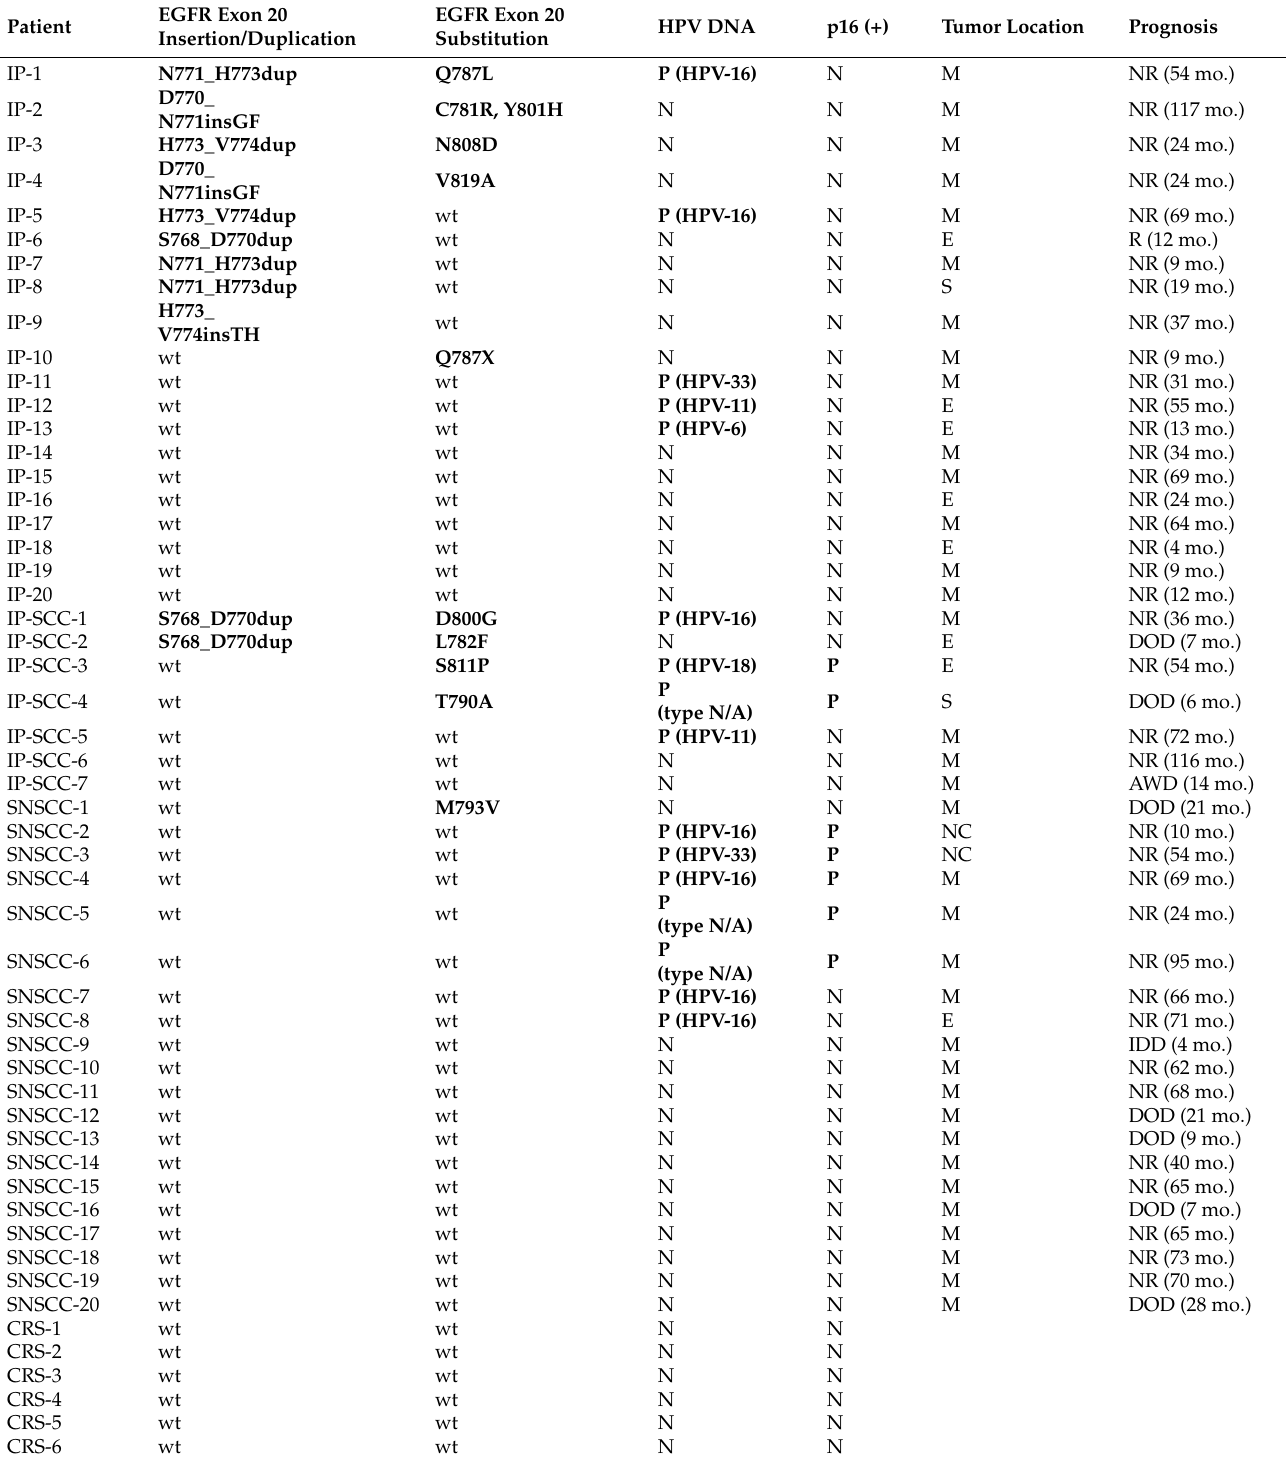
Table 3. EGFR mutations and HPV infection in individual